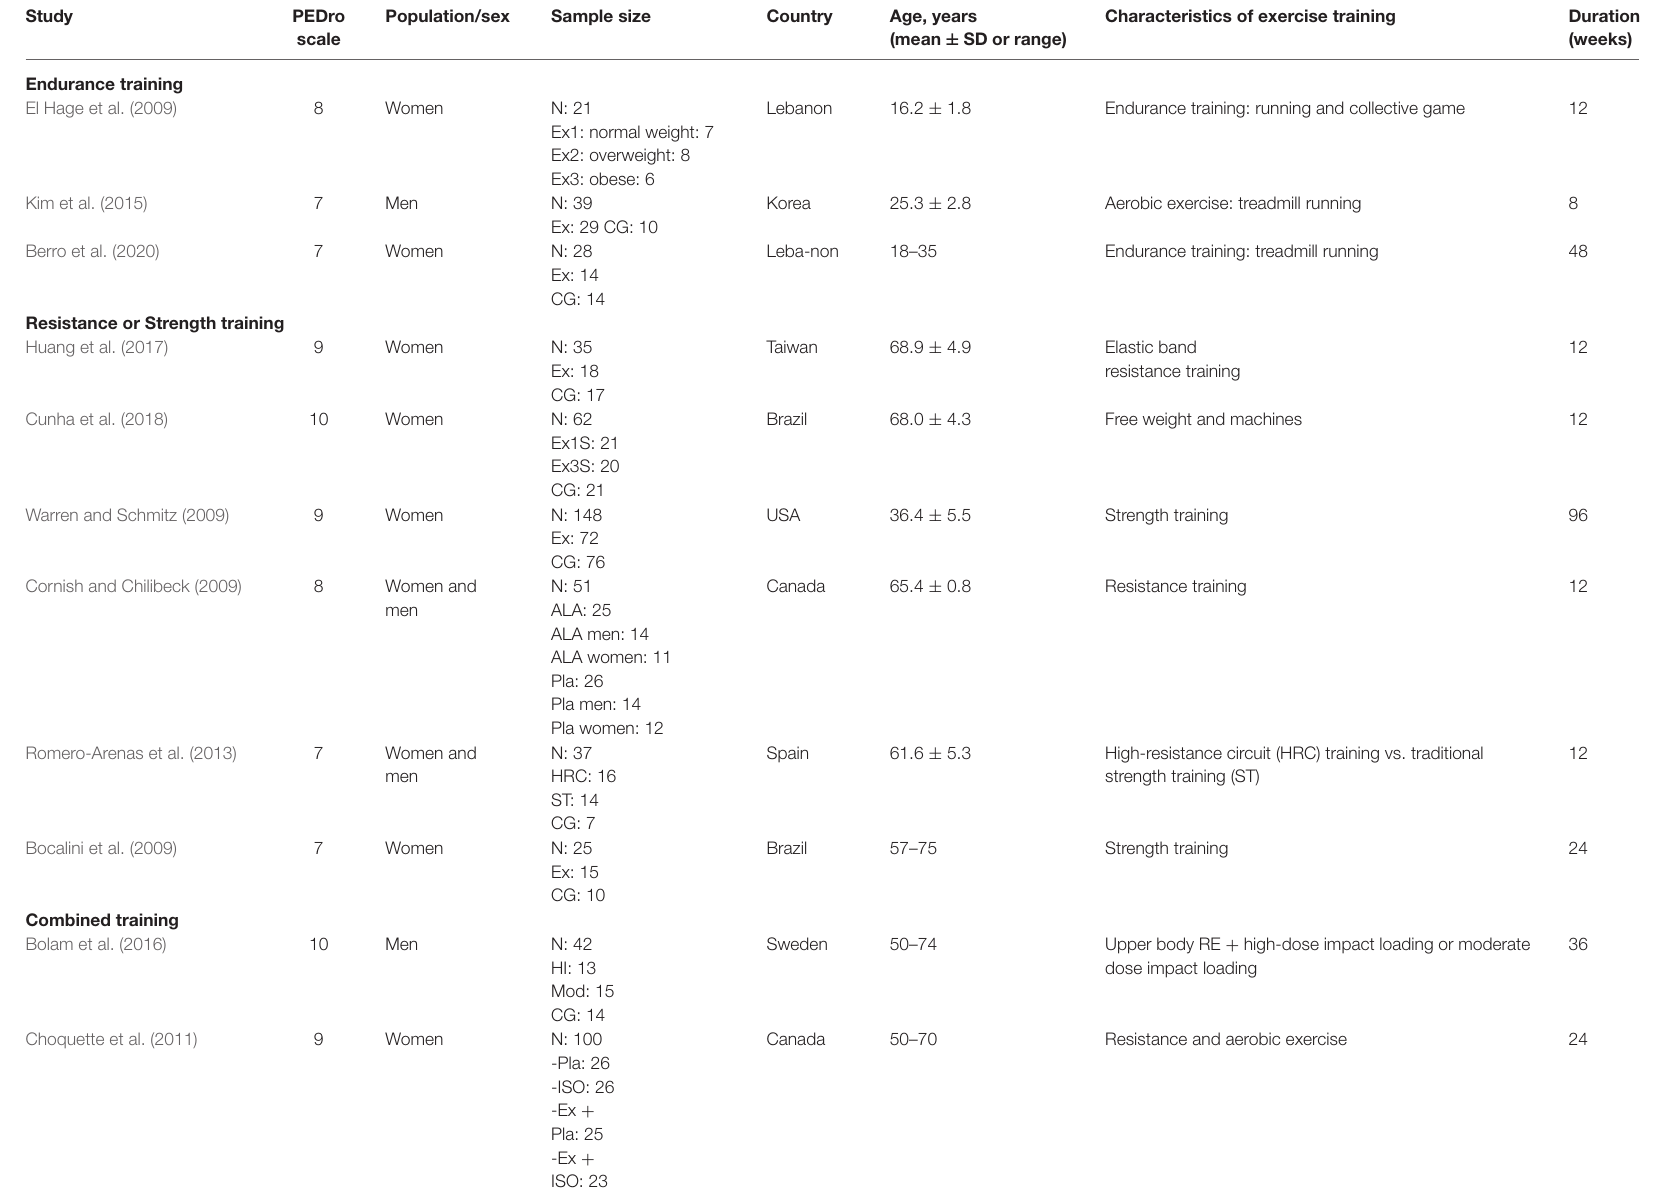
TABLE 2 | Characteristics of the studies that examined the effect of exercise training on bone health indices in individual with obesity. Study PEDro